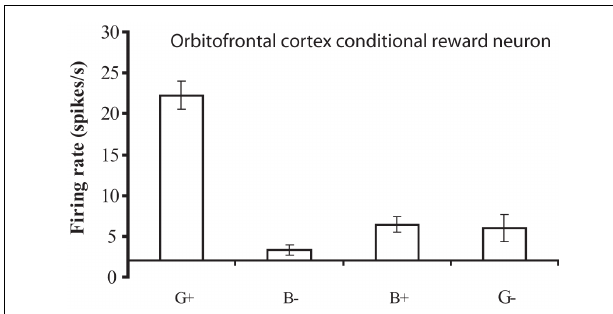
FIGURE 5 |A conditional reward neuron recorded in the orbitofrontal cortex which responded only to the Green stimulus when it was associated with reward (G + ), and not to the Blue stimulus when it was associated with reward (B + ), or to either stimuli when they were associated with a punisher, the taste of salt (G − and B − ). The mean firing rate ± SEM is shown. (AfterThorpe et al.,